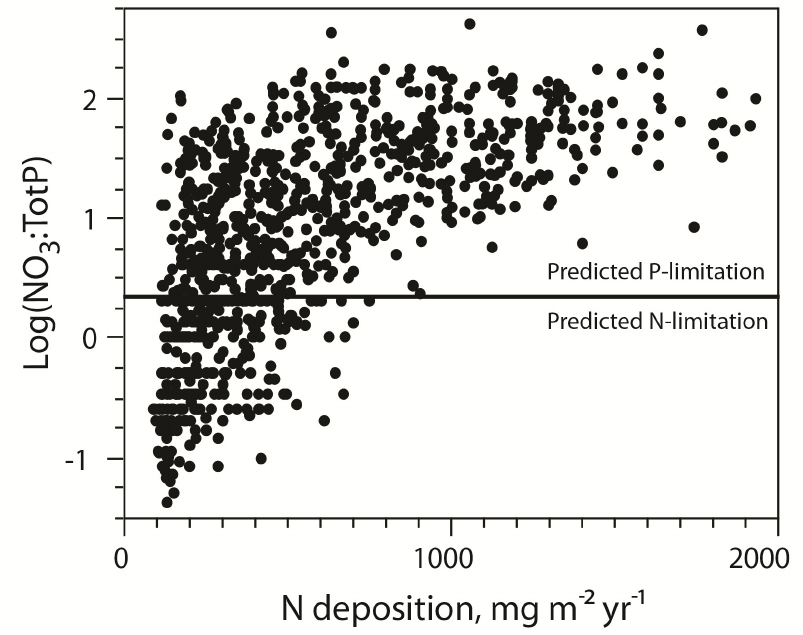
:TP and DIN-deposition and the potential shift Figure 4. The relationship between NO 3 from N to P-limitation of aquatic autotrophs (following [35]). See [19] for details on